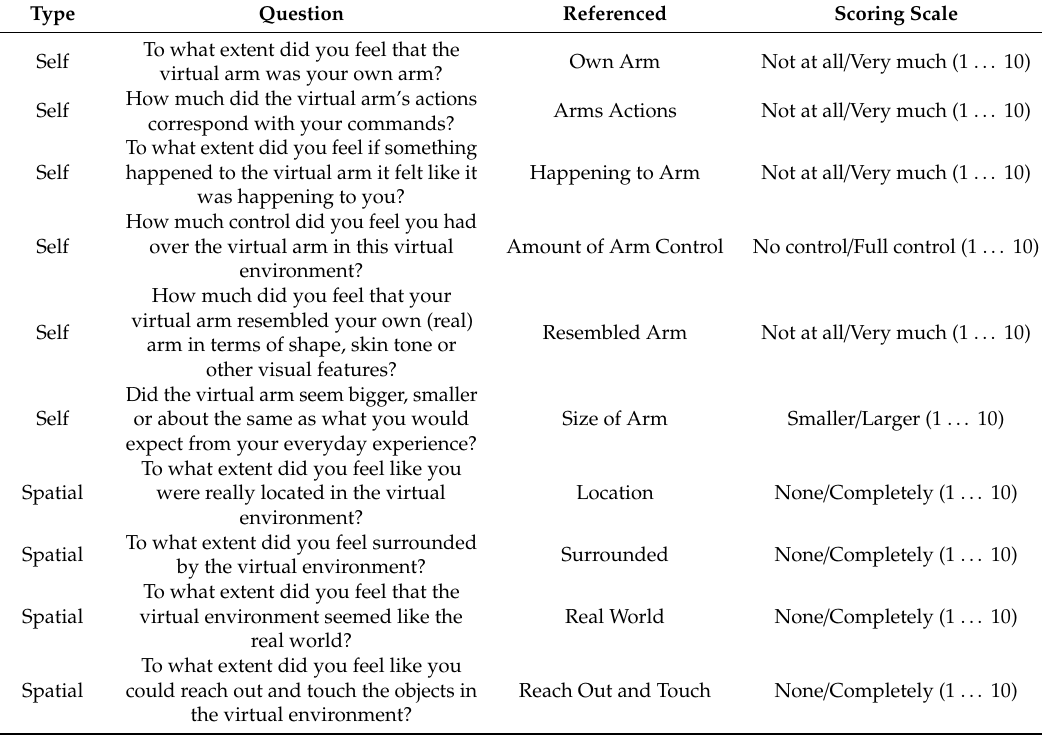
Table 1. Individual questions on Embodiment